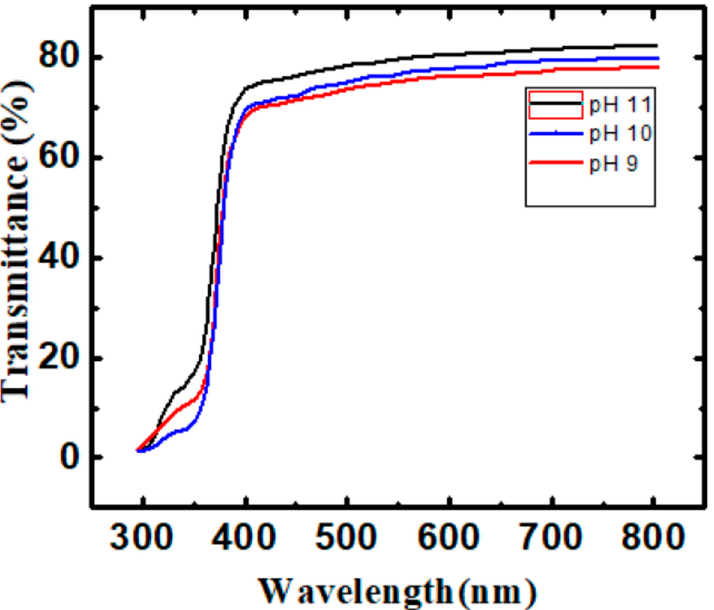
Figure 3. Transmittance of ZnO nanostructured thin films with wavelength ( λ ) for pH 9, pH 10, and Figure 3. Transmi tt ance of ZnO nanostructured thin fi lms with wavelength ( λ ) for pH 9, pH 10, and pH 11. pH 11.